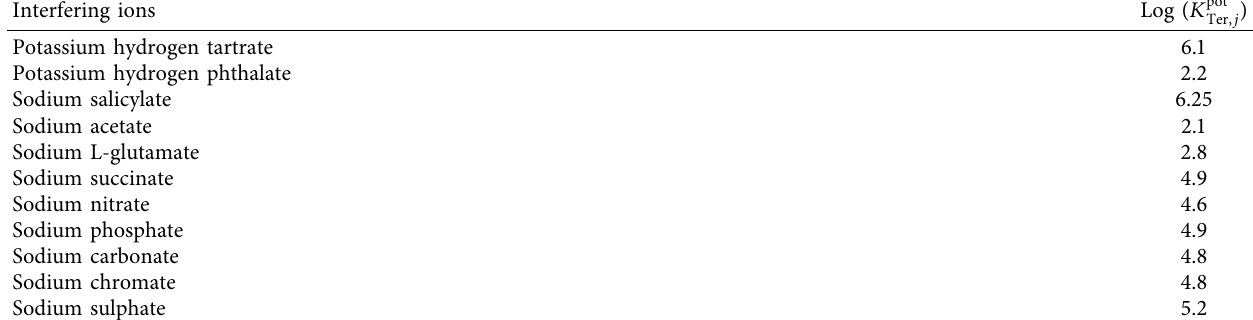
Table 2: Selectivity coefcients of the terbinafne microchip in the presence of interfering ions.